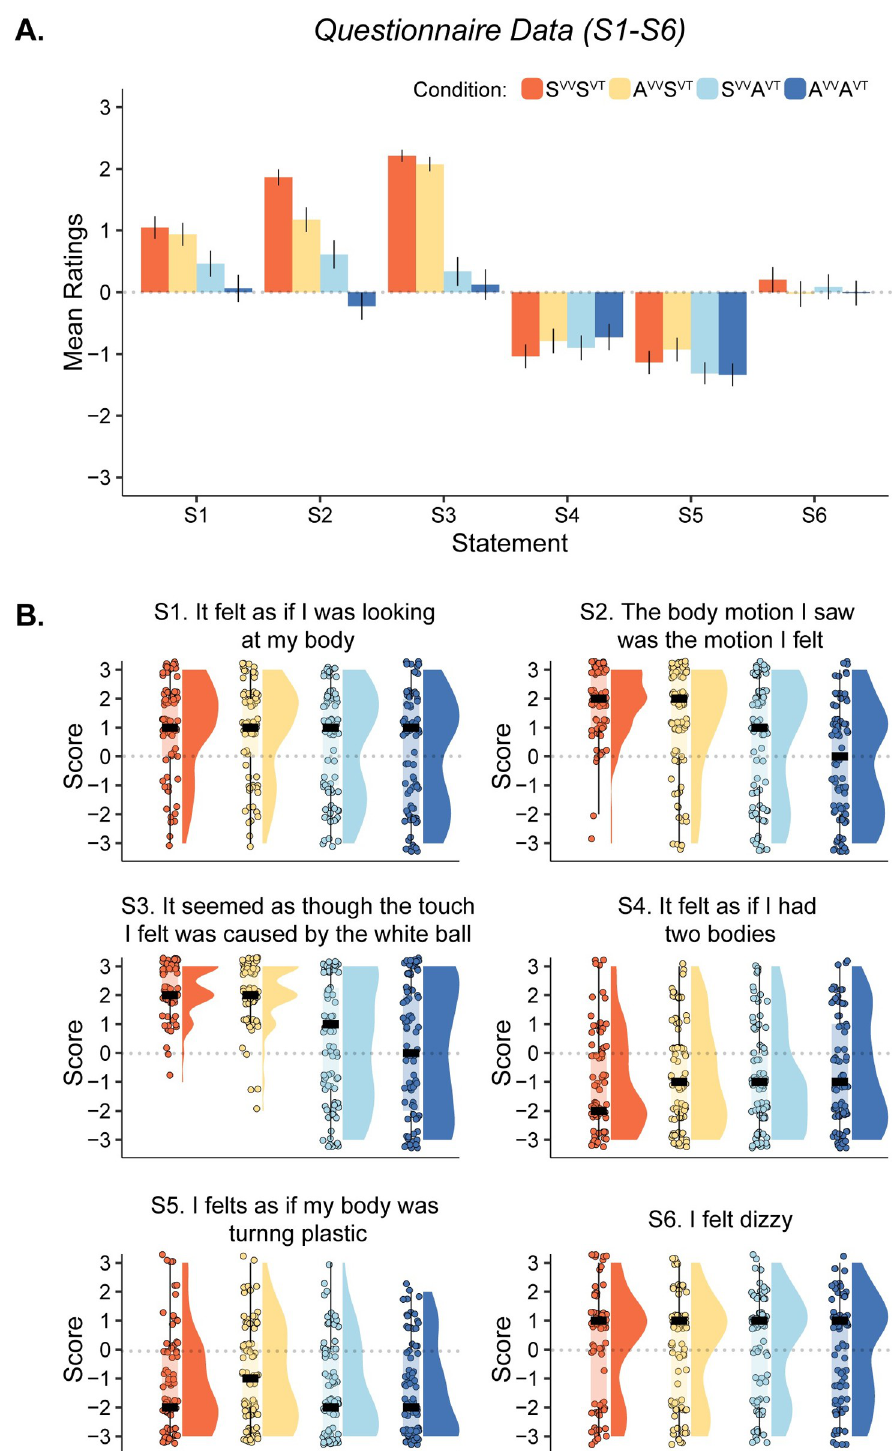
Fig 2. Plots for questionnaire results for statements S1–S6 (N = 80). ( A ). Means and standard errors of the mean are shown for all statements for illustrative purposes. ( B ). Raincloud plots show individual data points, medians, and distributions. Note: paired comparisons, descriptive statistics and post hoc comparisons are shown in S3 Fig, S3 and S4 Tables of the ‘Supporting Information–Section II’ in S1 File, respectively.